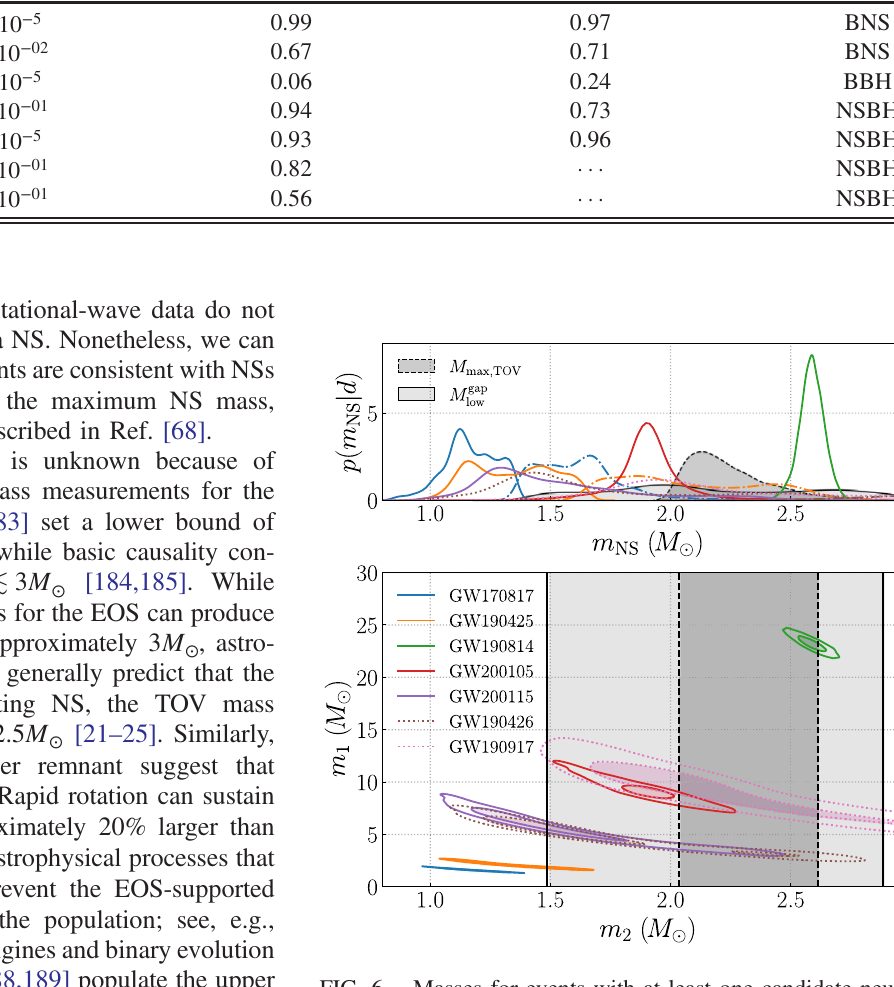
FIG. 6. Masses for events with at least one candidate neutron star. Upper panel: one-dimensional posterior distributions for the masses of the candidate NSs, as compared to estimates of the maximum NS mass based on the dense-matter EOS [25] ( M ) and on the inferred location of the lower mass gap max ; TOV in Sec. IV ’ s PDB analysis ( M gap ). Primary components are shown low dash-dotted. GW190814 ’ s secondary component lies above both estimates of the maximum NS mass. Lower panel: two-dimen- sional 50% (shaded) and 90% (unshaded) credible regions for the binary masses of each candidate NS merger. The marginal events GW190426 and GW190917 are shown dotted. The 90% credible intervals of the maximum NS mass posterior inferred from the EOS and from the lower mass-gap location are also plotted. GW190814 occupies a distinct region of the m 1 - m 2 plane compared to the events deemed BNSs or